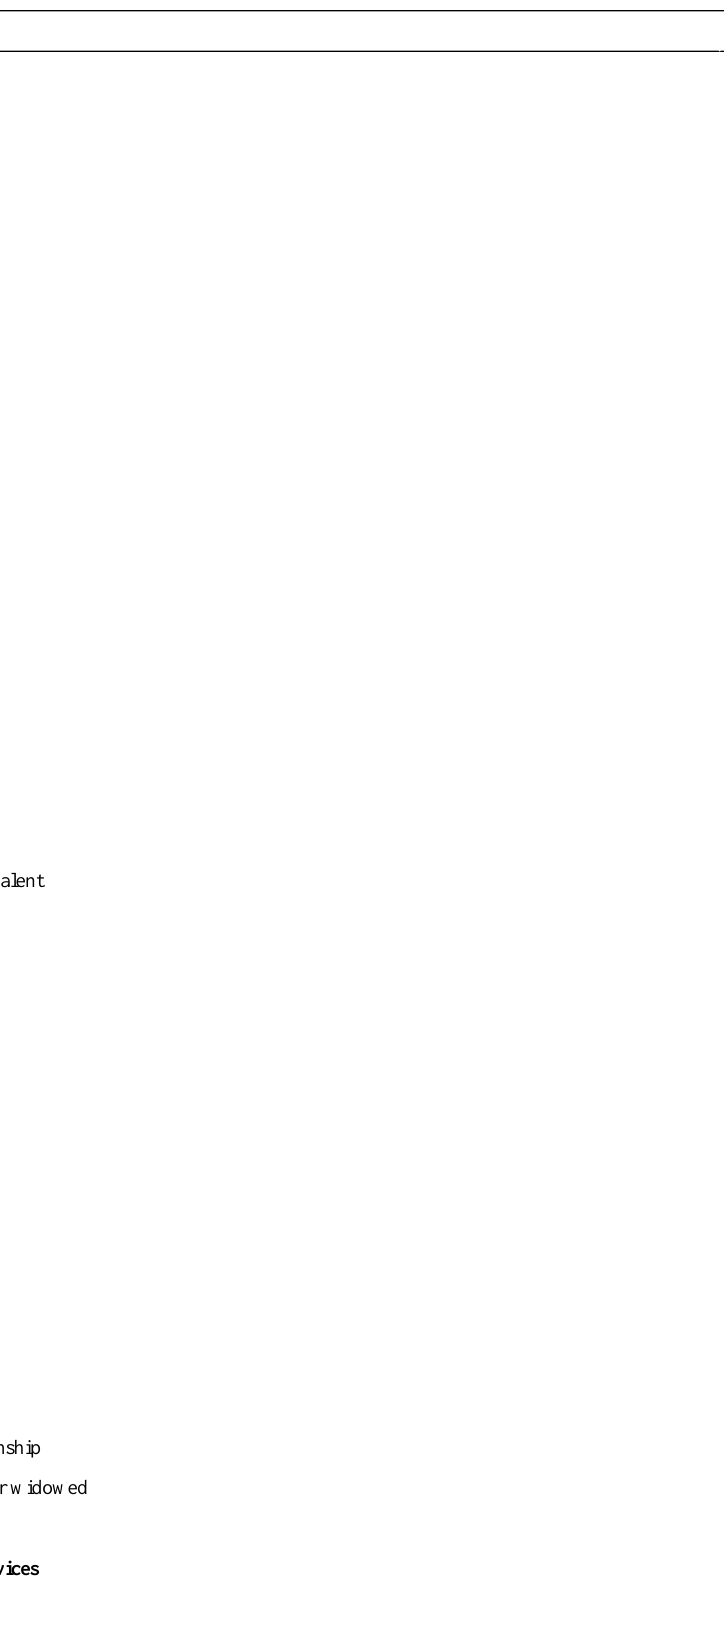
Table 1. Participant characteristics